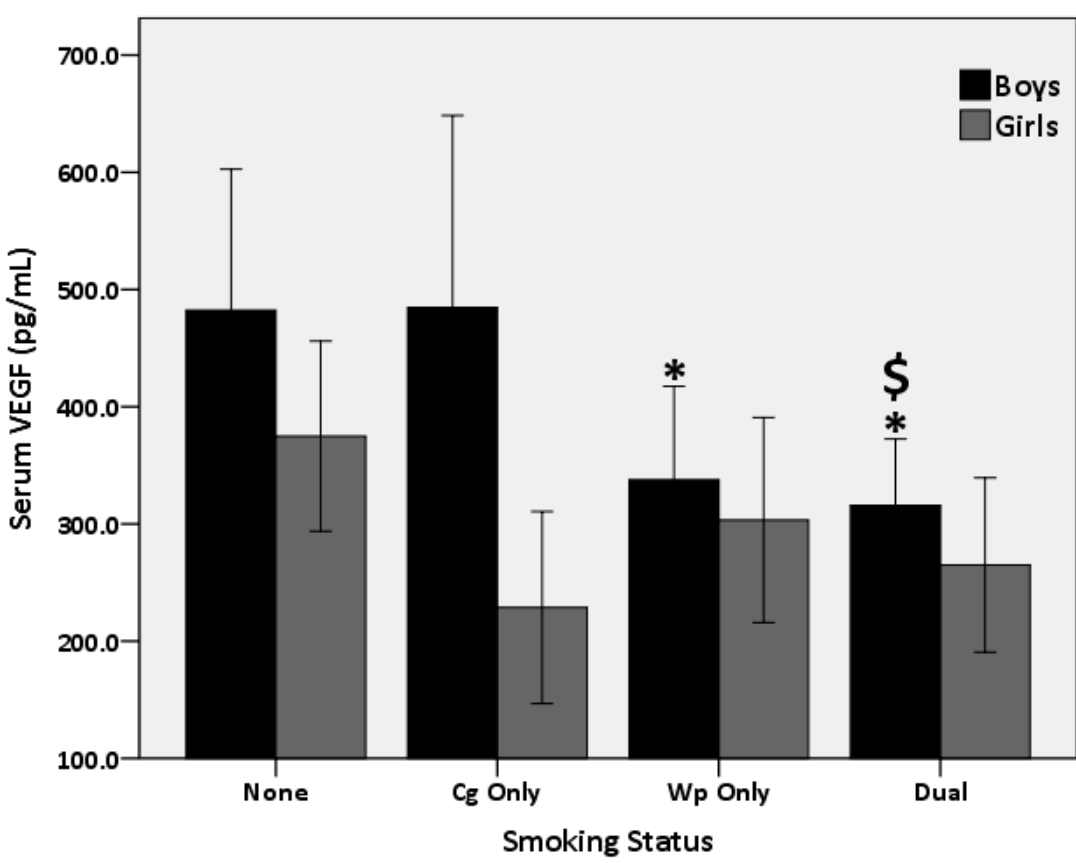
Figure 2. Comparison in serum VEGF levels between boys and girls Smoking Cigarette Only, Waterpipe Only, and Dual Smokers versus nonsmokers (None). * p > 0.05 versus nonsmokers. $ p < 0.05 versus Cigarette Only.